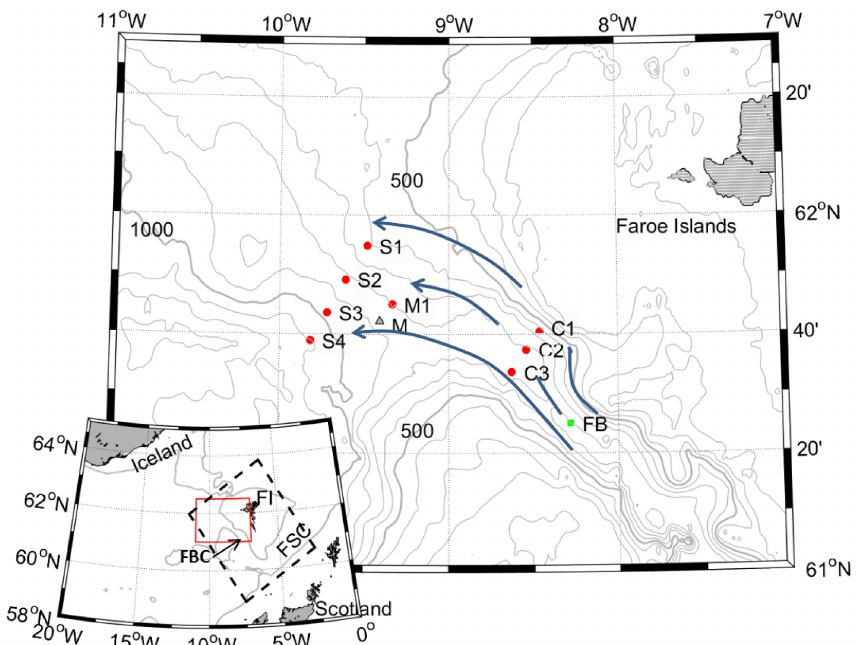
Figure 1. Map showing the study region. Isobaths are shown every 100m (thin, grey lines) and every 500m (thick, grey lines). The locations of the moorings are indicted by red labelled circles (Ullgren et al., 2015) and green squares (Hansen and Østerhus, 2007), and the overflow is indicated by the blue arrows. The location of the virtual mooring “M” (extracted from the model) is shown by the grey triangle. The arrows indicate the path of the FBC overflow. The inset shows the model domain (dashed, black box) and the study area (red box). The 500m isobaths are shown in grey. Place names are indicated as FBC – Faroe Bank Channel; FSC – Faroe Shetland Channel; and FI – Faroe